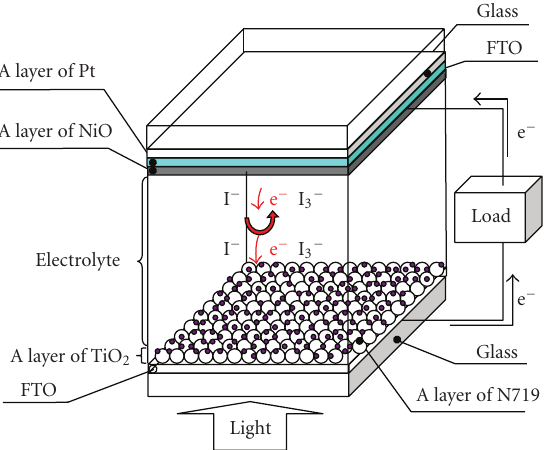
Figure 1: Schematic of the dye-sensitized solar cell with a Pt/NiO counter